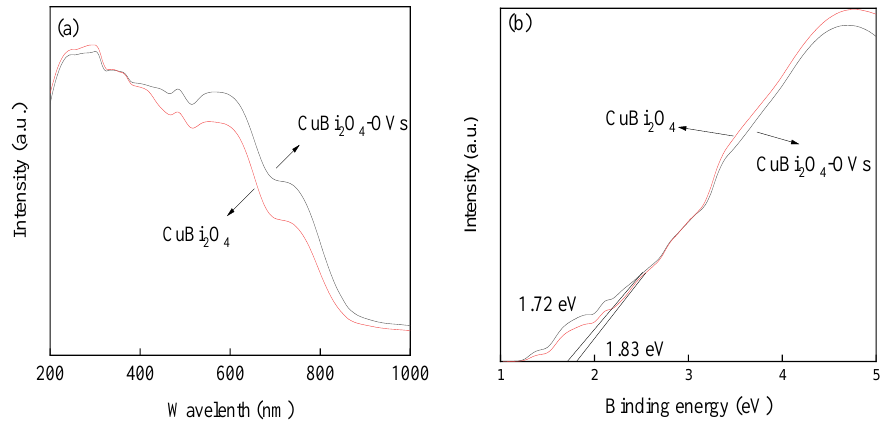
Figure 5. UV/vis diffusion reflectance spectra of as-prepared catalysts. Figure 5. ( a , b ) UV / vis di ff usion reflectance spectra of as-prepared